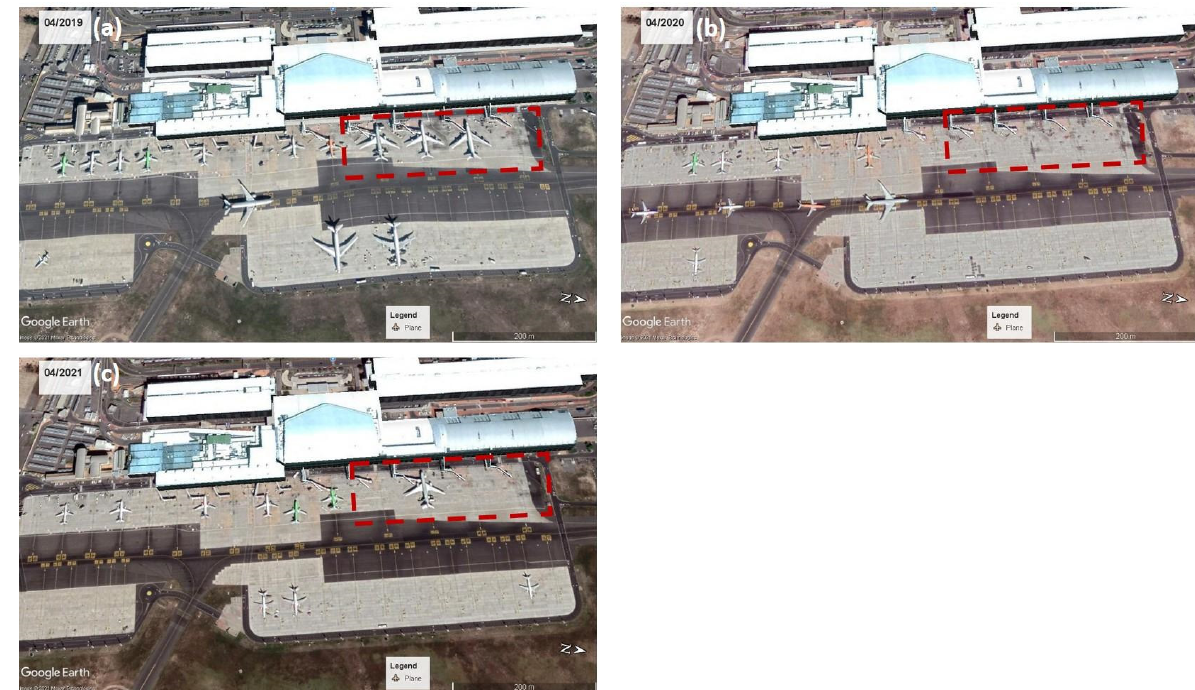
Figure 4. Google Earth image of Cape Town International Airport (FACT) ( a ) before the Level-5 lockdown, ( b ) during the lockdown Level-5, and ( c ) after the Level-5 lockdown.